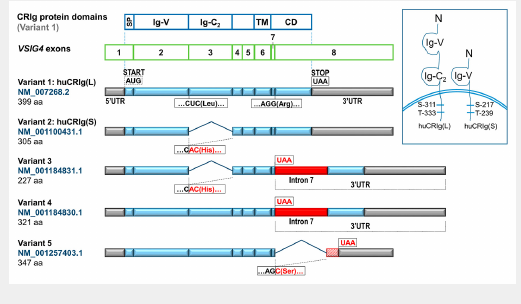
Schematic representation of the CRIg protein domains aligned with the five VSIG4 splice variant transcript structures. The transcripts structures are derived from the NCBI Reference Sequence Database (RefSeq) using the following mRNA accession numbers: